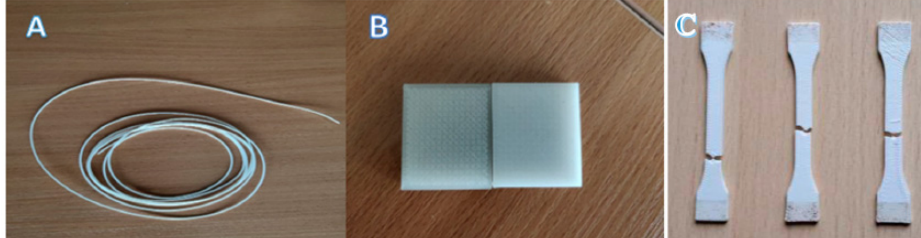
Figure 2. Experimental samples: ( A ) extruded ABS filament; ( B ) 3D printed ABS samples with different concentrations of TiO 2 fillers for attenuation experiments; ( C ) 3D printed ABS samples (ISO527-2 specimen 1A) containing different concentrations of TiO 2 after tensile stress and strain tests.